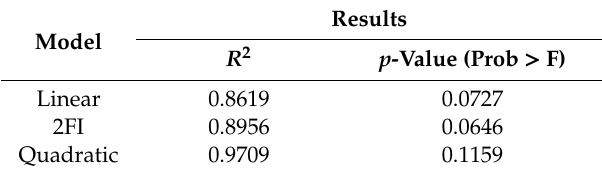
Table 3. Results of model fitting and lack of fit test in Box–Behnken design.